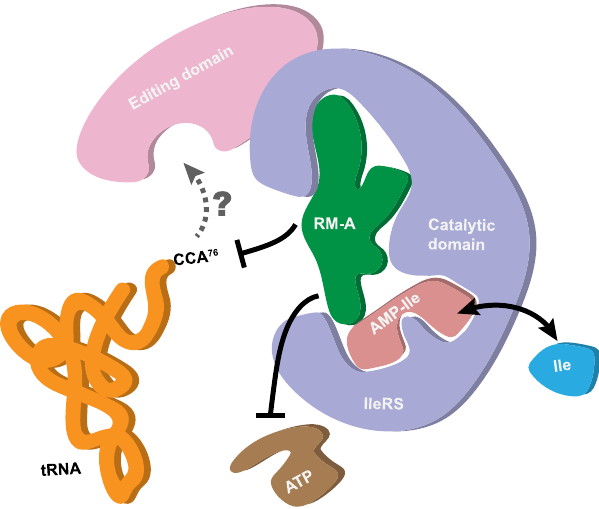
Fig. 6 Schematic diagram of the inhibition of eukaryotic IleRS by RM-A. RM-A occupies the binding site of the 3 ′ CCA end of tRNA Ile on the catalytic domain of eukaryotic cytoplasmic IleRS. Thus, it blocks the productive binding of tRNA Ile to the catalytic domain, while the alternative binding of tRNA Ile to the editing domain of IleRS might not be affected. RM- A may also partially con fl ict with the phosphate groups of ATP. In contrast, the substrate L -isoleucine and the intermediate product Ile-AMP could co- bind with RM-A to the aminoacylation pocket of